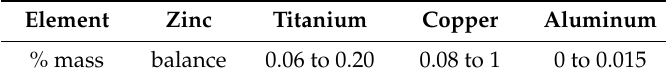
Table 2. Chemical composition of zinc